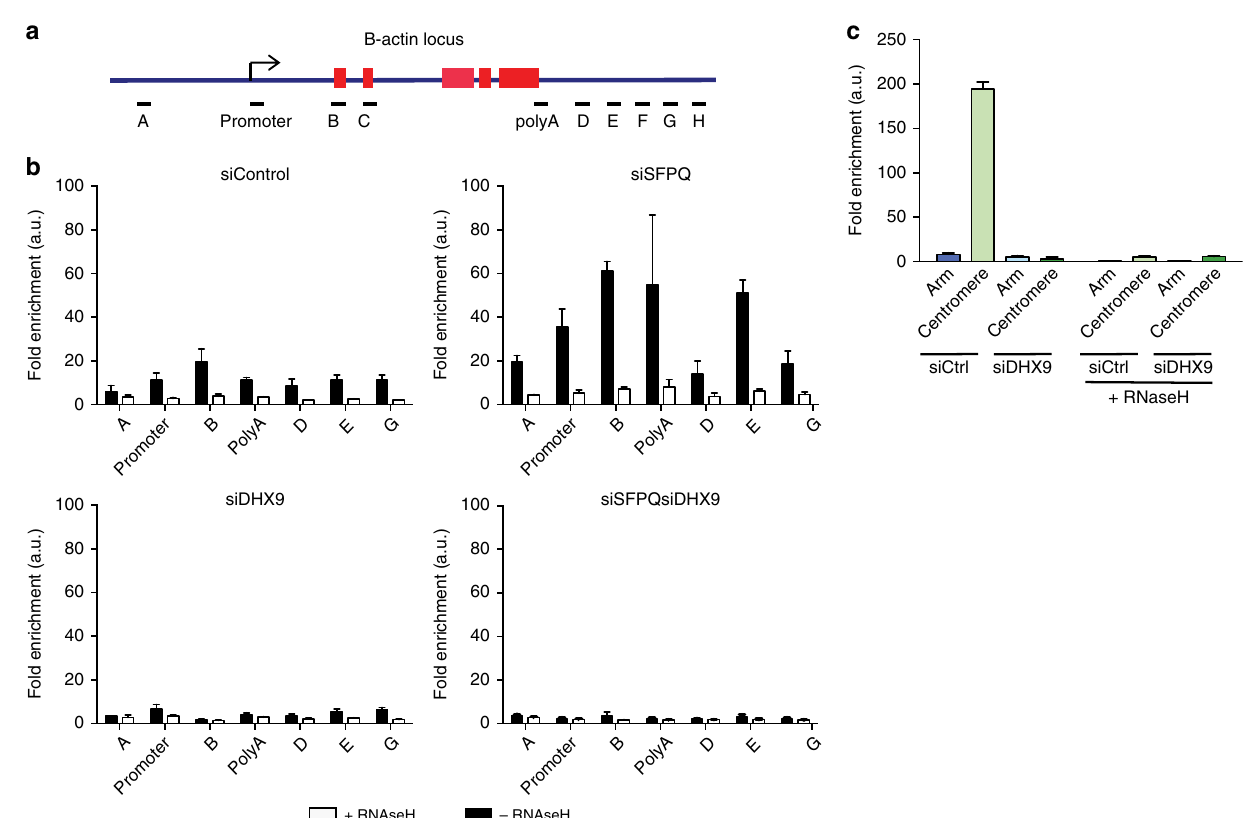
Fig. 6 DHX9 promotes the formation of pathological and non-pathological R-loops. a Diagram of the Β -actin locus depicting relative position of primer pairs used for qPCR in DNA – RNA immunoprecipitation (DRIP) and chromatin immunoprecipitation (ChIp) experiments. Exons are depicted as red boxes. b DRIP analysis at the Β -actin locus using S9.6 antibody. Quantitative PCR was performed using primers to the indicated regions of the Β -actin locus. Data are represented as fold enrichment compared to control immunoprecipitations. Data are an average of three independent experiments. c DRIP analysis of RNA – DNA hybrid at centromeric and fl anking arm regions of chromosome 1 in cells knocked down for DHX9. Samples were treated with RNaseH1 to remove DNA – RNA hybrid are